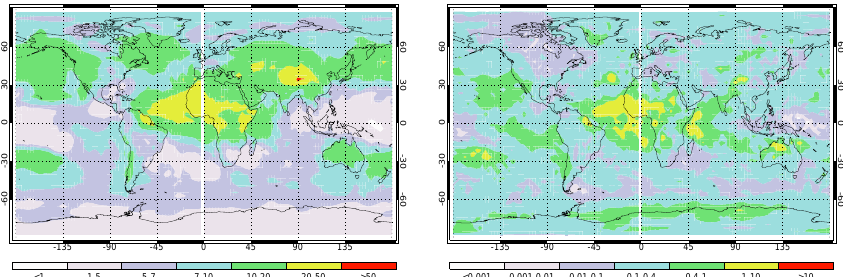
Fig. 3. Left: IN concentration (130–270hPa)L − 1 . Right: ICNC het (130–270hPa)L − 1 . Annual mean global distributions of heterogeneous IN concentrations ( N a , DU + N a , DU − COATED ) in L − 1 and of the resulting ice crystal number concentrations ( N i , DU + N i , DU − COATED ) in L − 1 averaged between 130 and 270 hPa. Note the different colour bars.